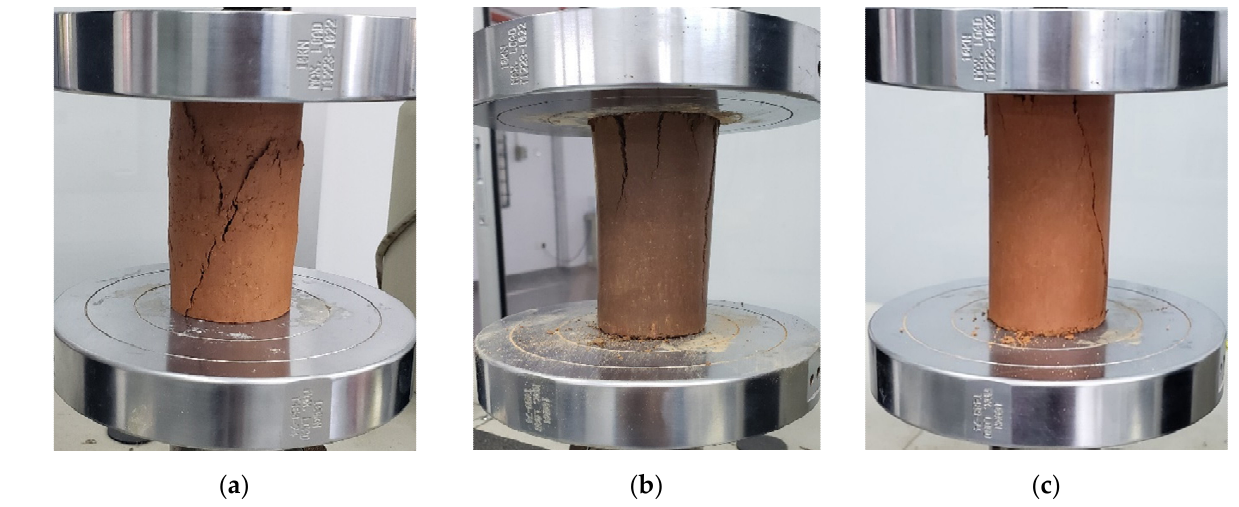
Figure 4. Failure patterns of UCS test: ( a ) lateritic soil, ( b ) AC-treated soil, and ( c ) lime-treated soil.